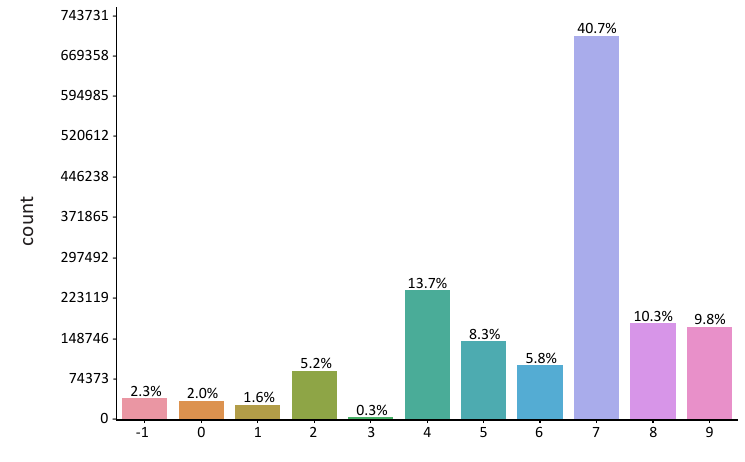
Fig. 4. Distribution of classes throughout the entire data